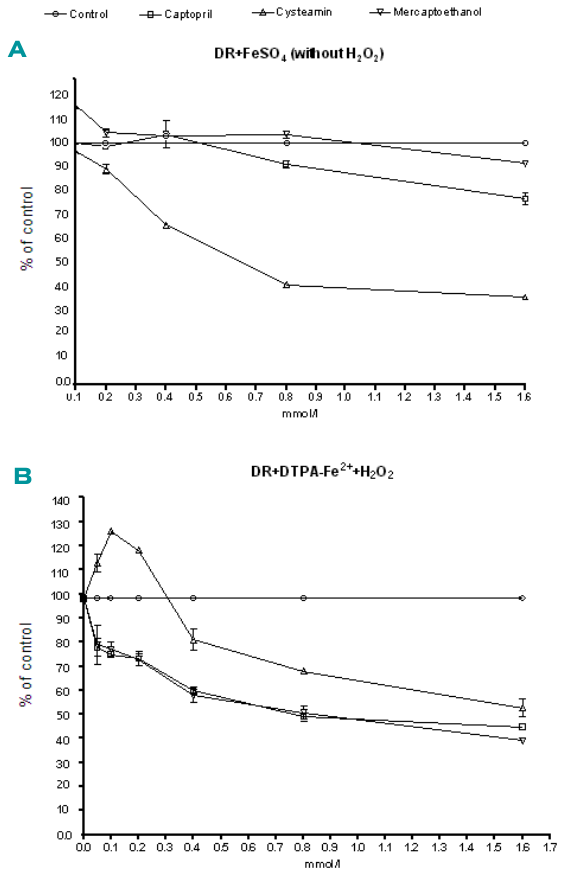
Figure 1. Effects of capropril, cysteamine and mercaptoethanol on TBARs formation. Reaction mixtures: A) 10 mM potassium phosphate buffer, pH 7.4; 0.1 and 2 mM deoxyribose. B) 10 mM potassium phosphate mM FeSO 4 O and 2 mM deoxyribose. buffer, pH 7.4; 0.1 mM DTPA-Fe 2+ , 0.5 mM H 2 2 Incubation was carried out for 30 min at 37°C in the presence of increasing concentrations of the tested compounds. Values are the mean ± SEM of 10 experiments and are expressed in % inhibition NBT reduction. Significant differences versus corresponding controls at *p <0.001.